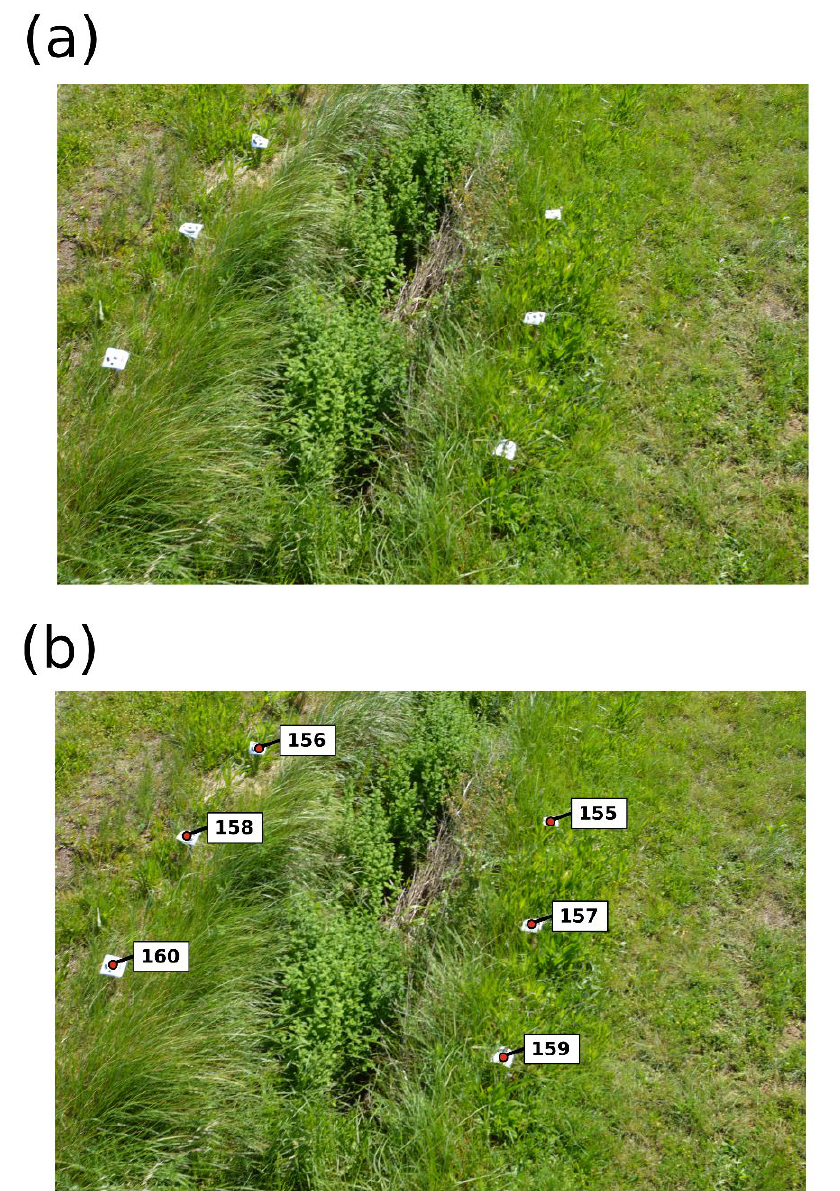
Figure 3. Illustration of automatic recognition of the targets on a picture using Photoscan Pro © . ( a ) original image; ( b ) image with recognized targets (boxes linked to a red